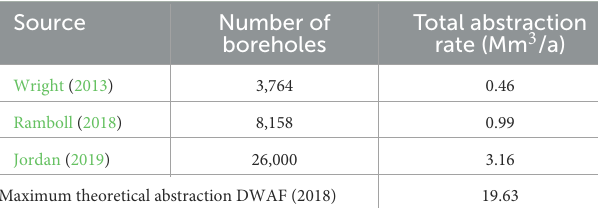
TABLE 1 Summary of estimated boreholes (Kring,